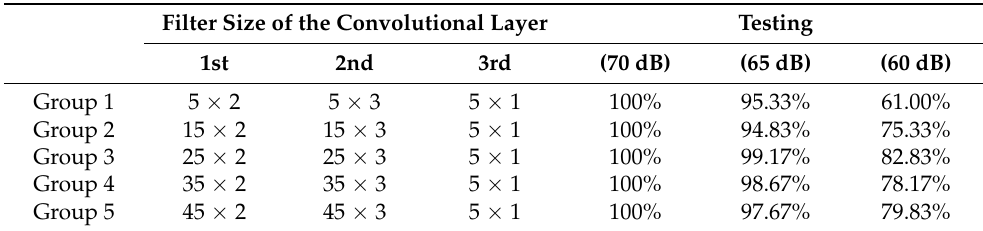
Table 2. Results of different filter